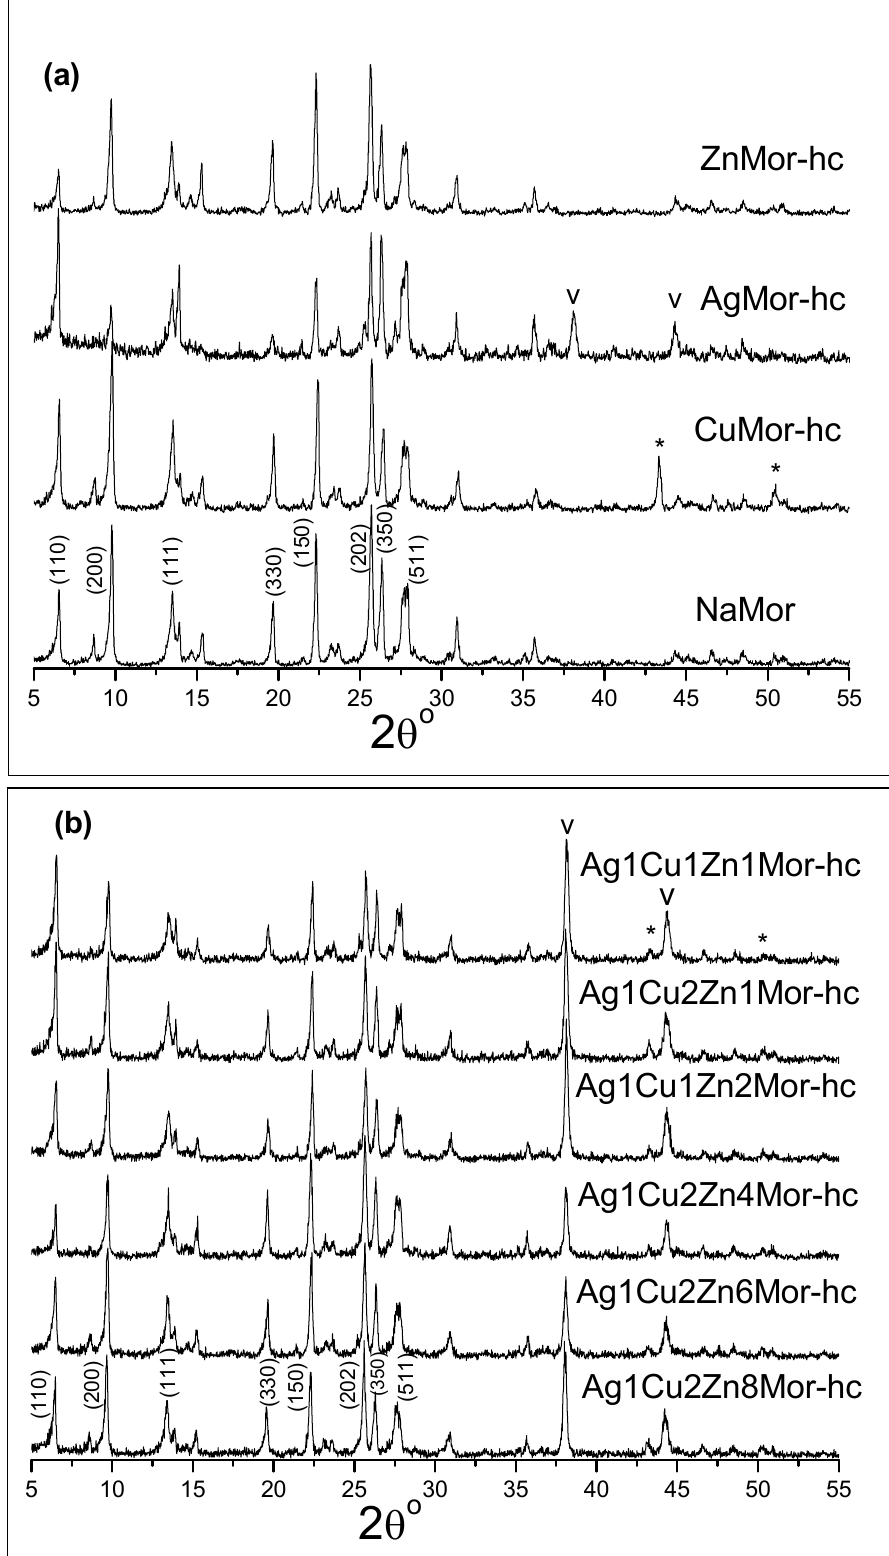
Figure 4. XRD patterns of the selected samples reduced in hydrogen and then also cooled in hydrogen. The peaks for metallic copper and silver are marked with asterisk (*) and “v” symbols, respectively. The pattern of the NaMor sample is included also.